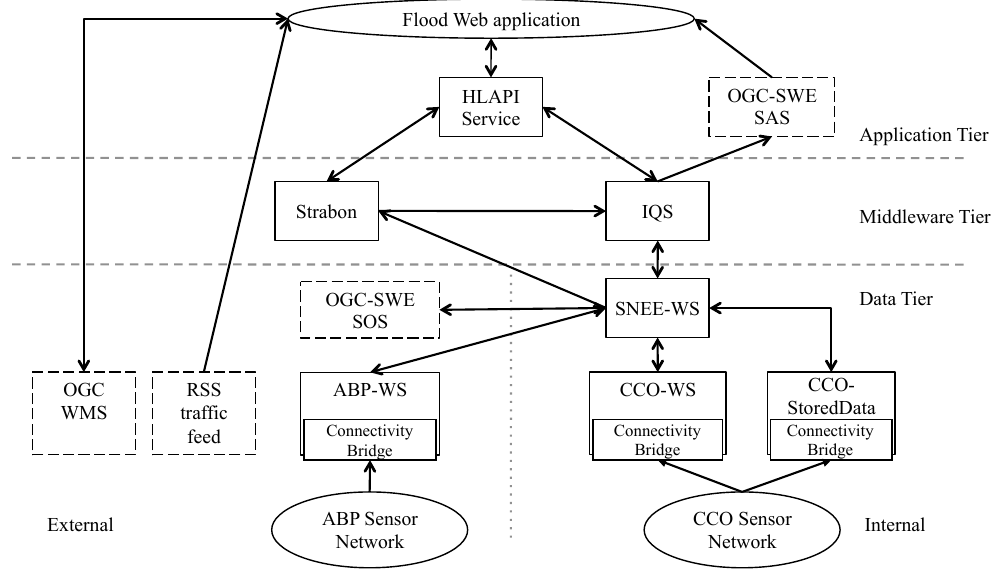
Figure 3. Deployment of semantic sensor web service instances to satisfy the flood surge scenario. Registration interactions have been omitted for clarity of presentation. All